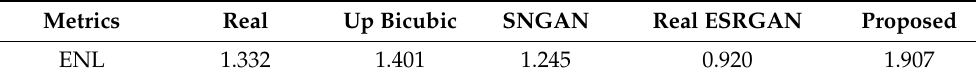
Table 3. Valuation results of real SAR images